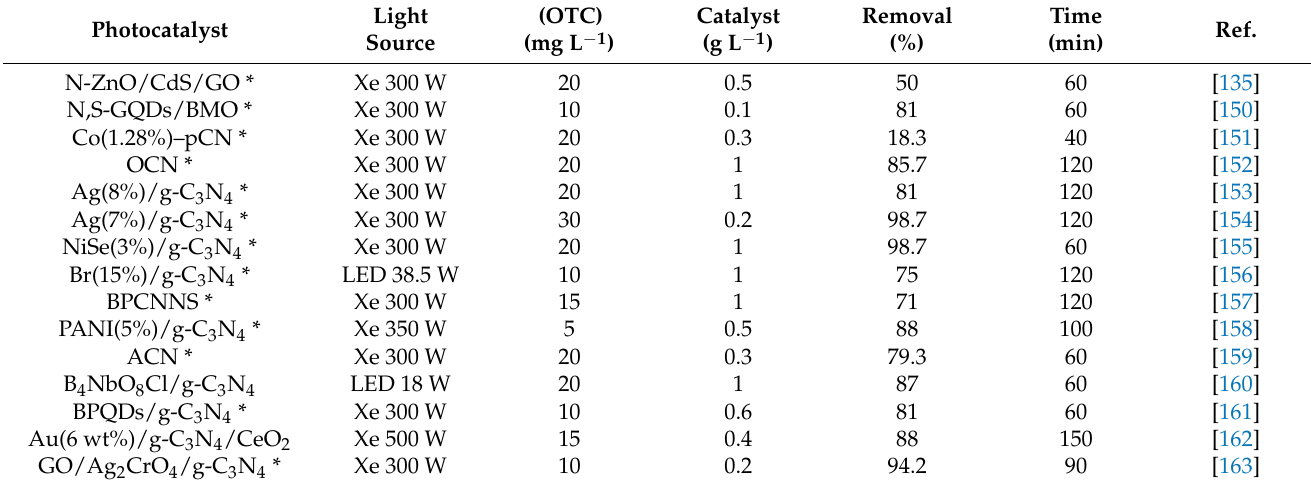
Table 5. OTC degradation over heterogeneous g-C 3 N 4 -based photocatalysts.